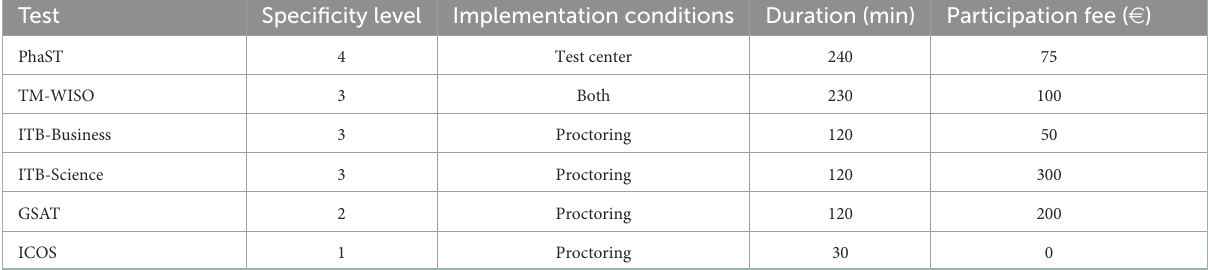
TABLE 1 Overview of the six scholastic aptitude